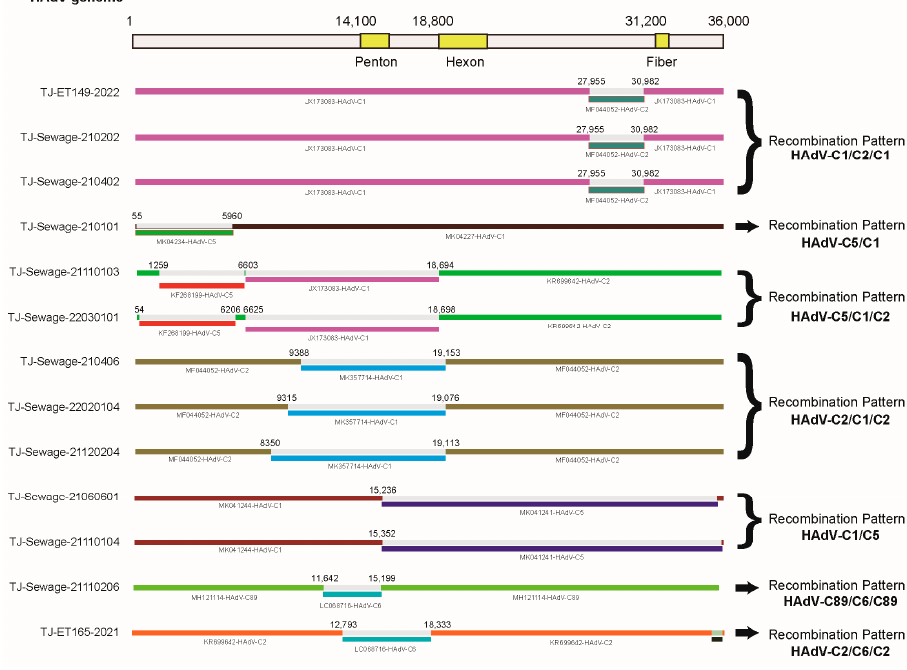
Figure 3. Schematic representation of recombination events in 13 genomes within 7 recombination patterns. A genetic map of human adenovirus species C (HAdV-C) is shown at the top. Analysed genomes are represented by a blue rectangle, the major parents are represented by a green rectangle, while the minor parents are represented by a purple rectangle. Breakpoints are identified based on the recombination detection program (RPD) version 4 output.